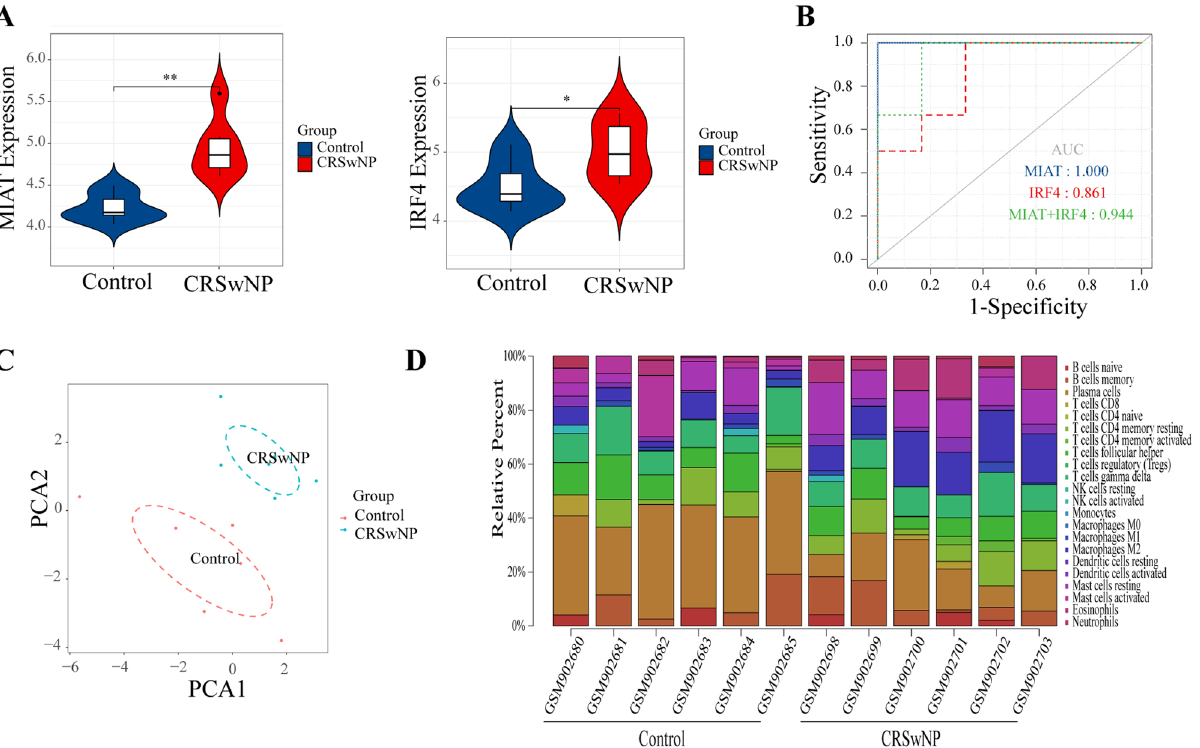
Figure 5. GSE36830 validation and evaluation of immune cell infiltration. ( A ) Expression pattern of MIAT and IRF4 in CRSwNP and control subjects. ( B ) The ROC curves of MIAT (blue dotted line), IRF4 (red dotted line), MIAT and IRF4 (green dotted line). ( C ) PCA cluster plot of immune cell infiltration performed on all samples. ( D ) Bar charts of 22 immune cell proportions in the CRSwNP and control groups. ROC, receiver operating characteristic; AUC, area under the receiver operating characteristic curve. * p value < 0.05, ** p value <